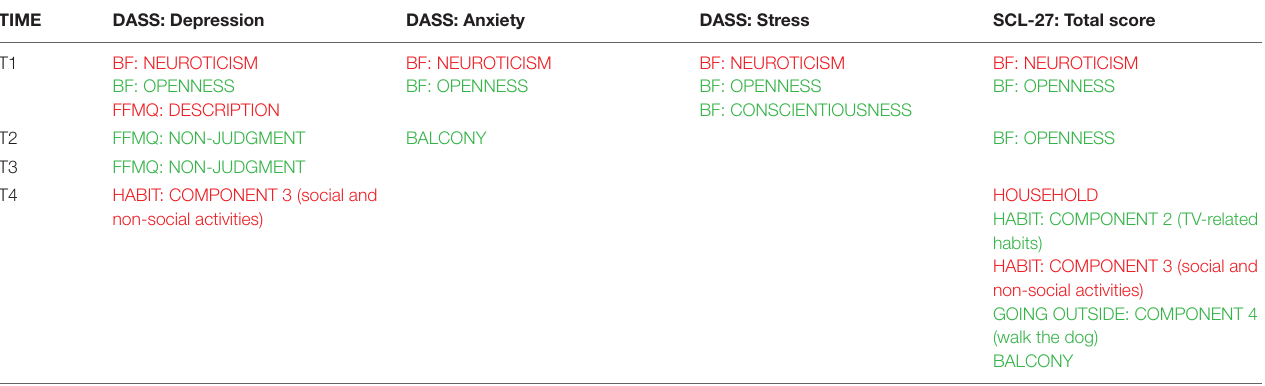
TABLE 7 | Summary of the main findings from cross-sectional